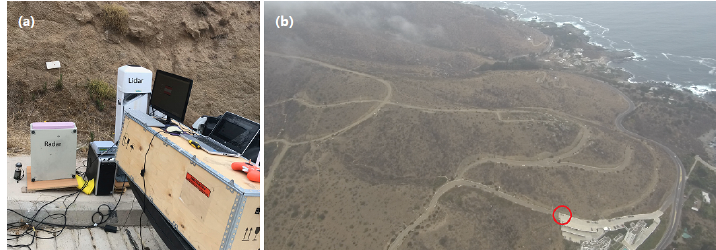
Figure 7. ( a ) the experimental setup for measuring clouds with the radar and Lidar; ( b ) image taken with a drone that shows the location of the experiment and in the top left corner you can see marine stratus clouds moving towards the sea. Close to the bottom right corner, the Radar and Lidar position (32 ◦ 30 (cid:48) 09.7 (cid:48)(cid:48) S, 71 ◦ 27 (cid:48) 35.6 (cid:48)(cid:48) W) is marked with a red